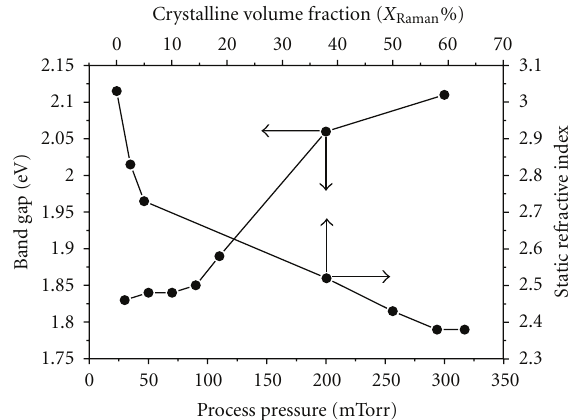
Figure 9: Variation of band gap as a function of process pressure for the films deposited by hot wire deposition method. Also, the variation of static refractive index with volume fraction of crystallites is depicted in the